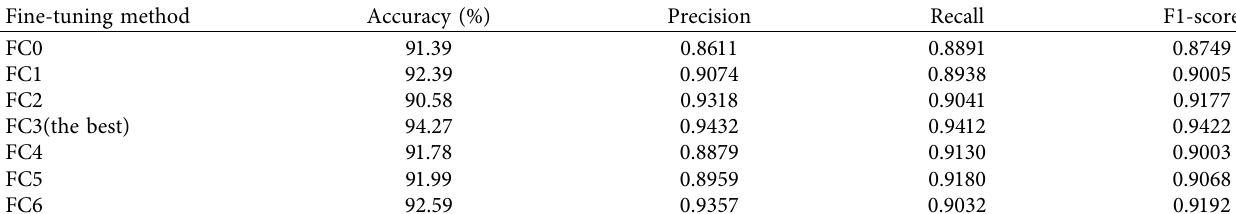
Table 2: Classification results of the ResNeXt-50(32 × 4d) model under different fine-tuning strategies.